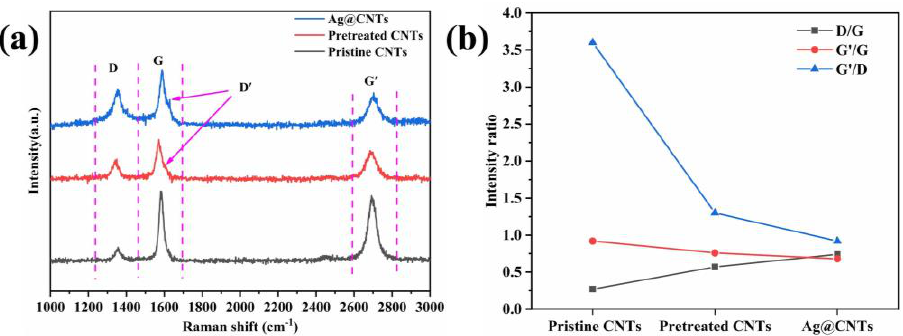
Figure 3. ( a ) Raman spectra of the pristine CNTs, pretreated CNTs and Ag-CNTs; ( b ) I D /I G , I Gʹ /I G , I Gʹ /I D intensity ratios of the pristine CNTs, pretreated CNTs and Ag-CNTs.